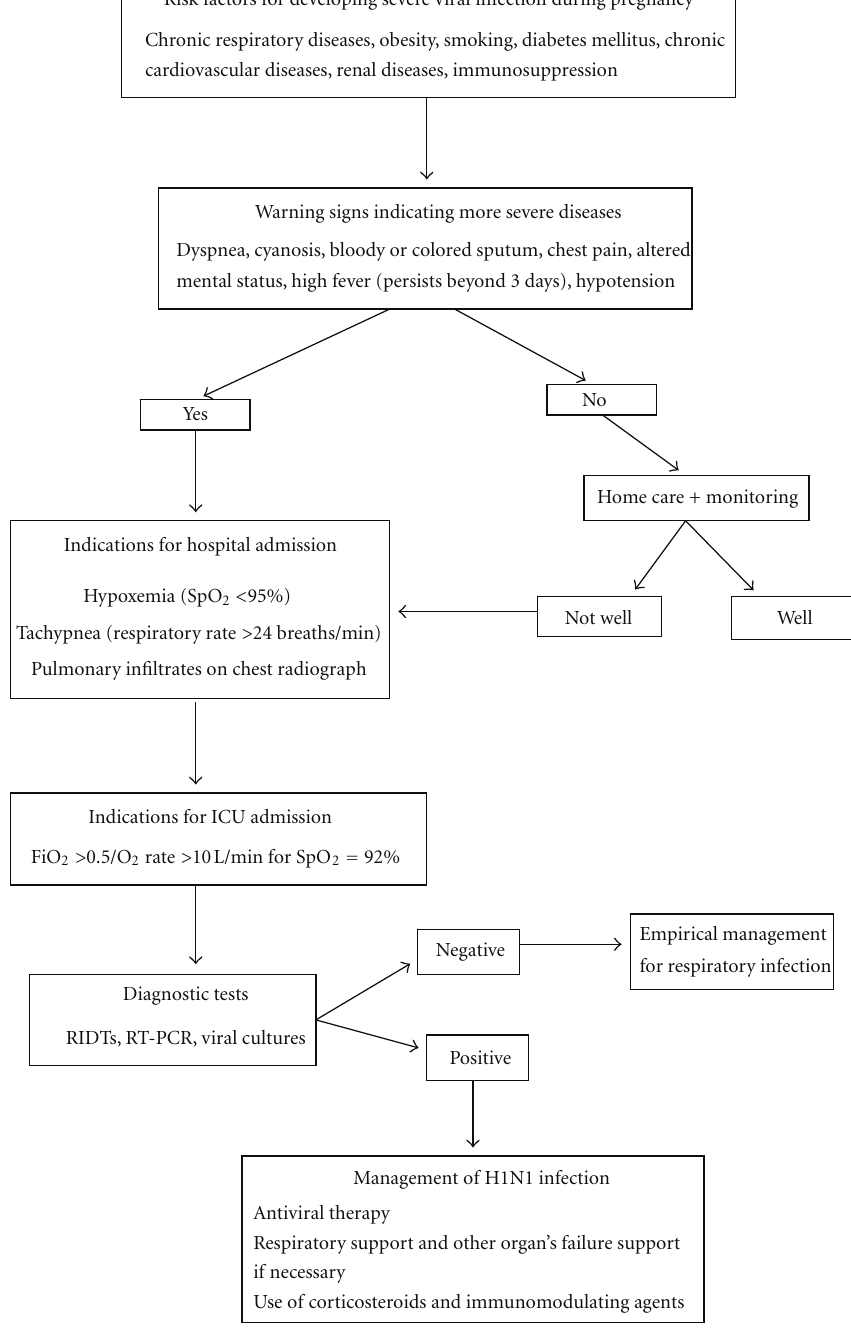
Figure 4: Diagnostic and management strategy for pregnant or postpartum women with novel influenza A (H1N1) viral infection (ICU: intensive care unit; RIDTs: rapid influenza diagnostic antigen tests; RT-PCR: real-time reverse transcription-polymerase chain reaction; CT: computed tomography; SpO 2 = oxygen